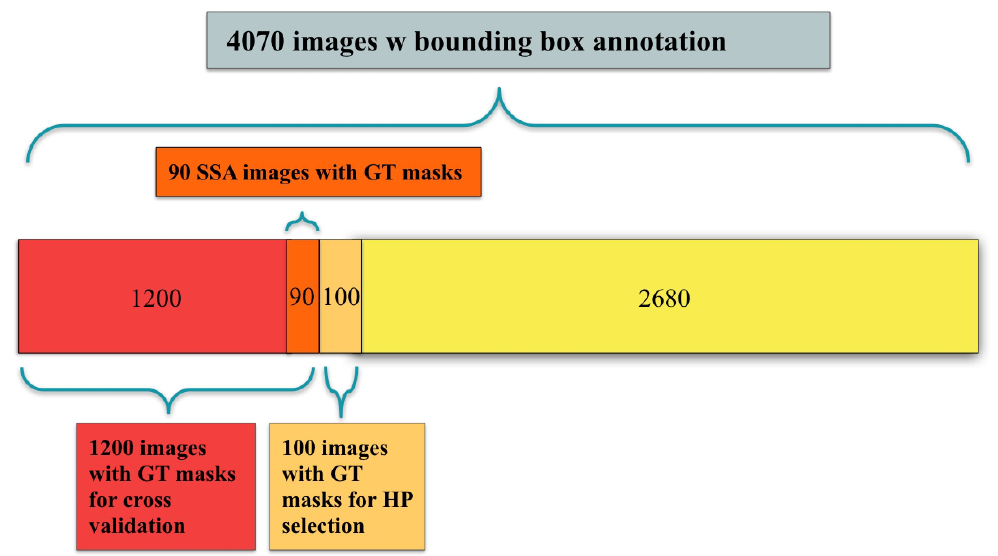
Figure 3. A breakdown of the 4070 polyp-containing images in training and testing: all 4070 images contain bounding box annotations of polyps, and a subset of 1300 images additionally contains human labeled ground truth (GT) segmentation masks. Among the 1300 images, 100 are used for hyperparameter (HP) selection and 1200 are used for model evaluation using cross-validation; 90 out of the 1200 images are sessile serrated adenomas